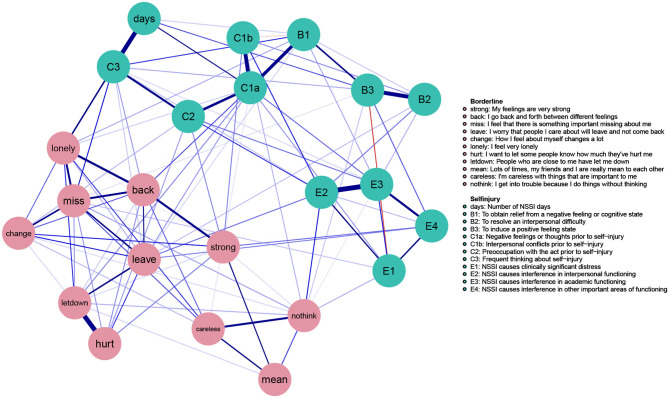
Full gLASSO network.